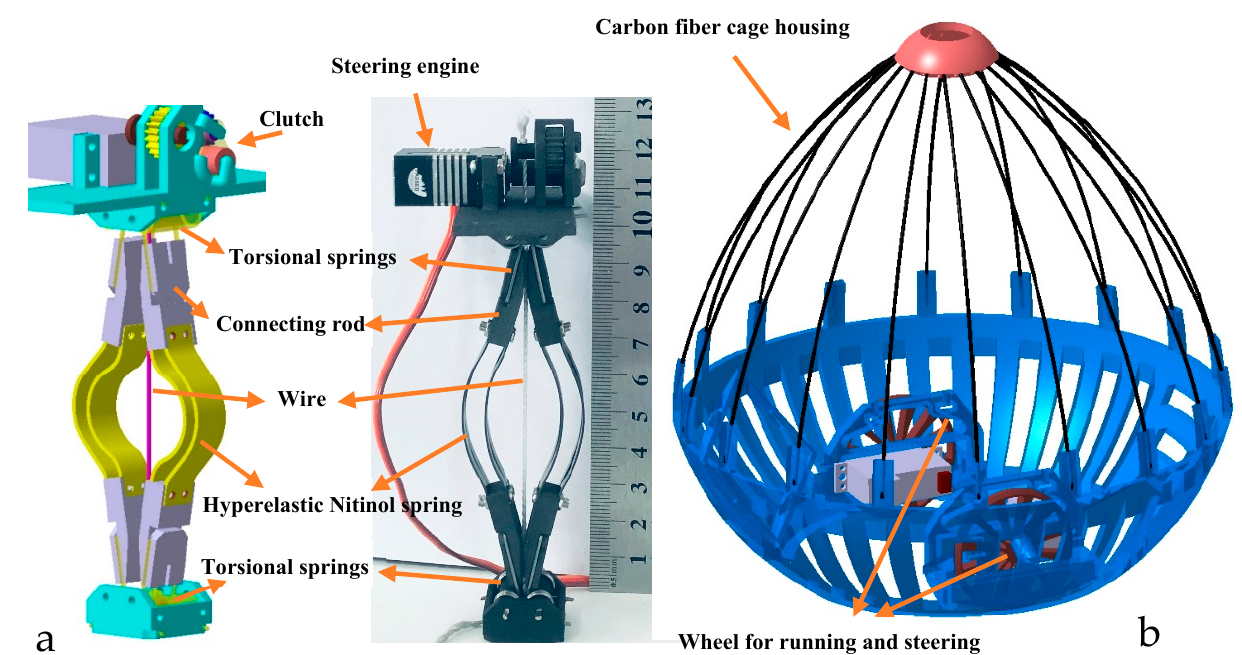
Figure 6. The two main units of the robot: the jumper unit ( a ) and the shell unit ( b ).